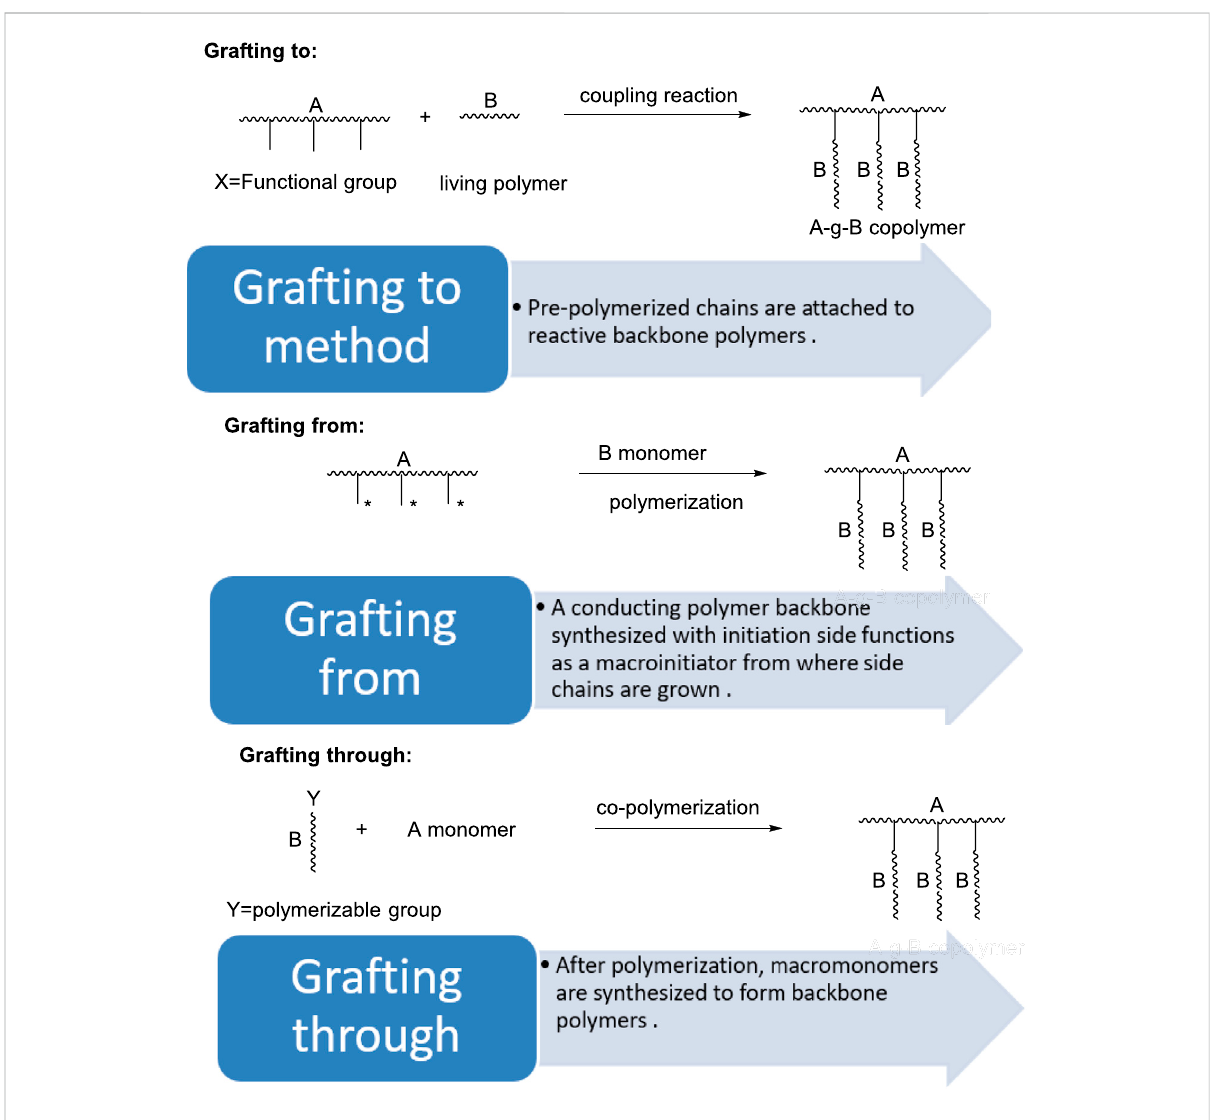
FIGURE 1 Strategies of polymer grafting: grafting to, grafting from and grafting